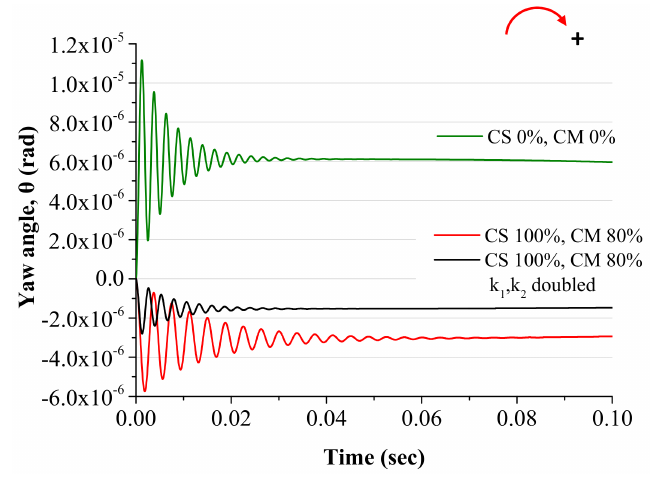
Figure 23. Yaw angles according to change of CM and CS .